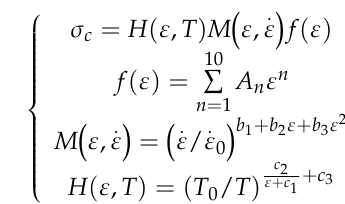
Figure 12. Stress–strain curves of UHMWPE at a strain rate of 1300 s − 1 and different temperatures.